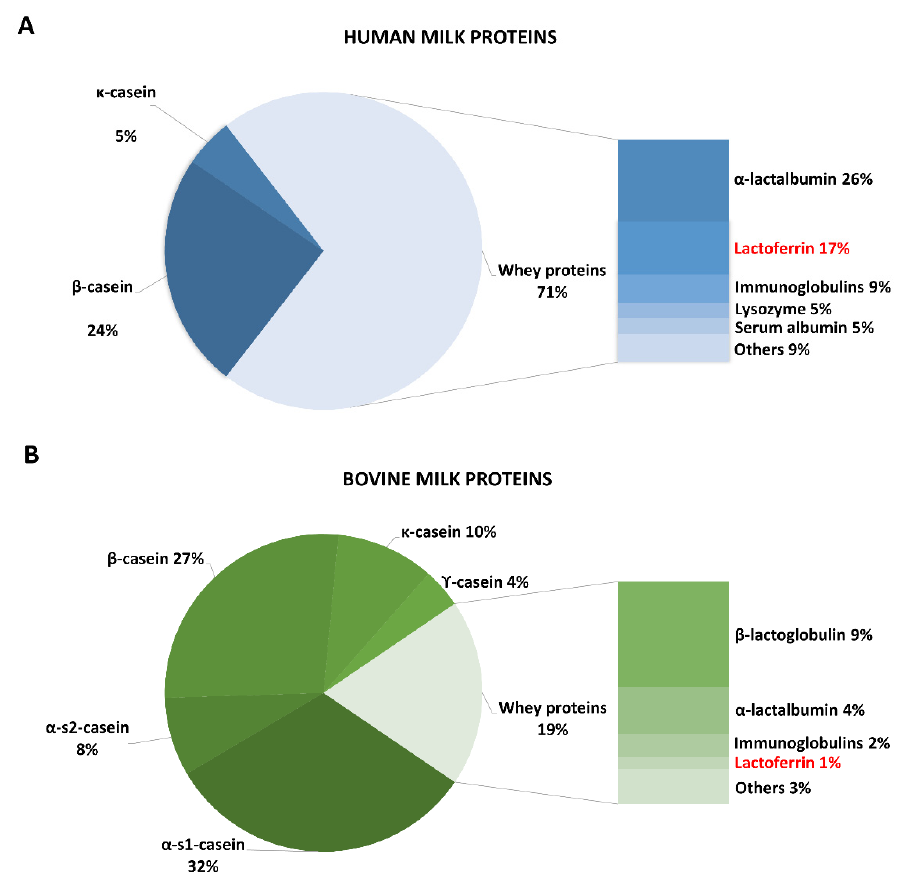
Figure 1. Percentage of the main proteins in human ( A ) and bovine ( B ) milk.